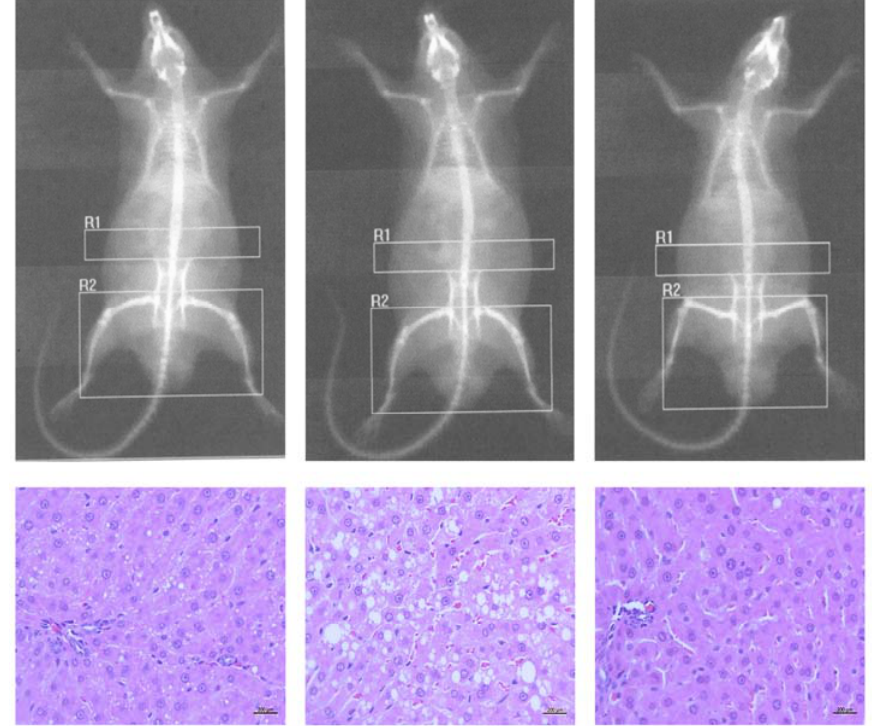
Figure 1. Imaging (DXA) and histological (H&E) findings. Control (left) and non ‐ supplemented high ‐ fat (HF; center) group and the group supplemented with GGG rind extract (HF+; right). Liver micrographs were captured at 400×. DXA conditions: dual energy 140/100 kVp, 2.5 mA average, 122 s, 60 Hz.